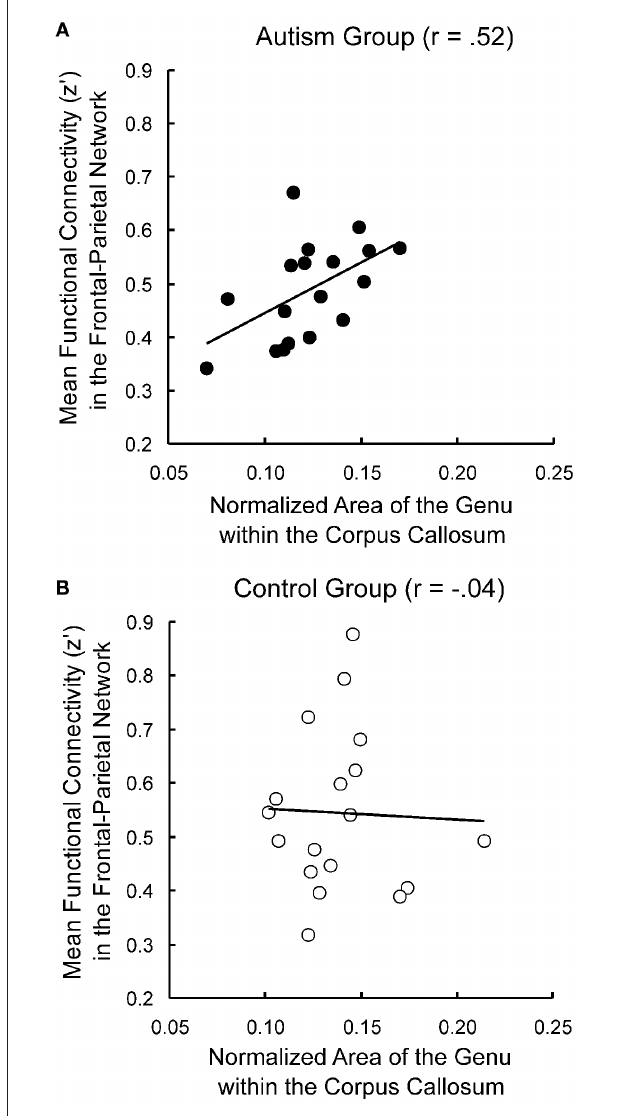
FIguRe 2 | Correlations between functional and anatomical connectivity. Functional connectivity is correlated with corpus callosum size in autism participants (A) but not control participants (B) . Adapted from Just et al.